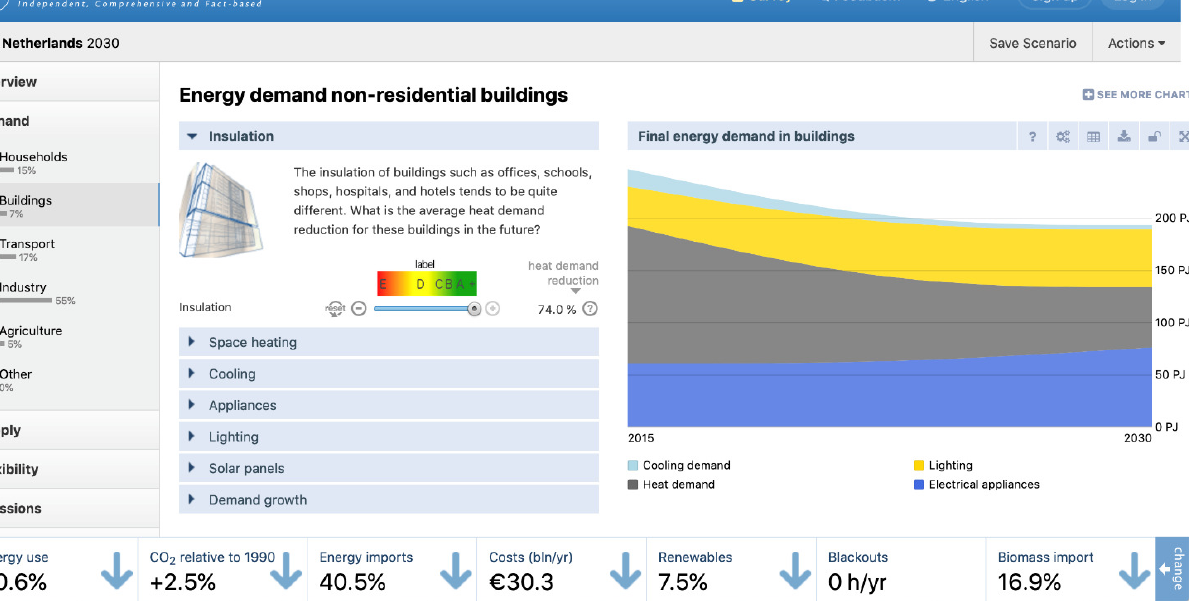
Figure 9. Screenshot from the ETM developed by Quintel